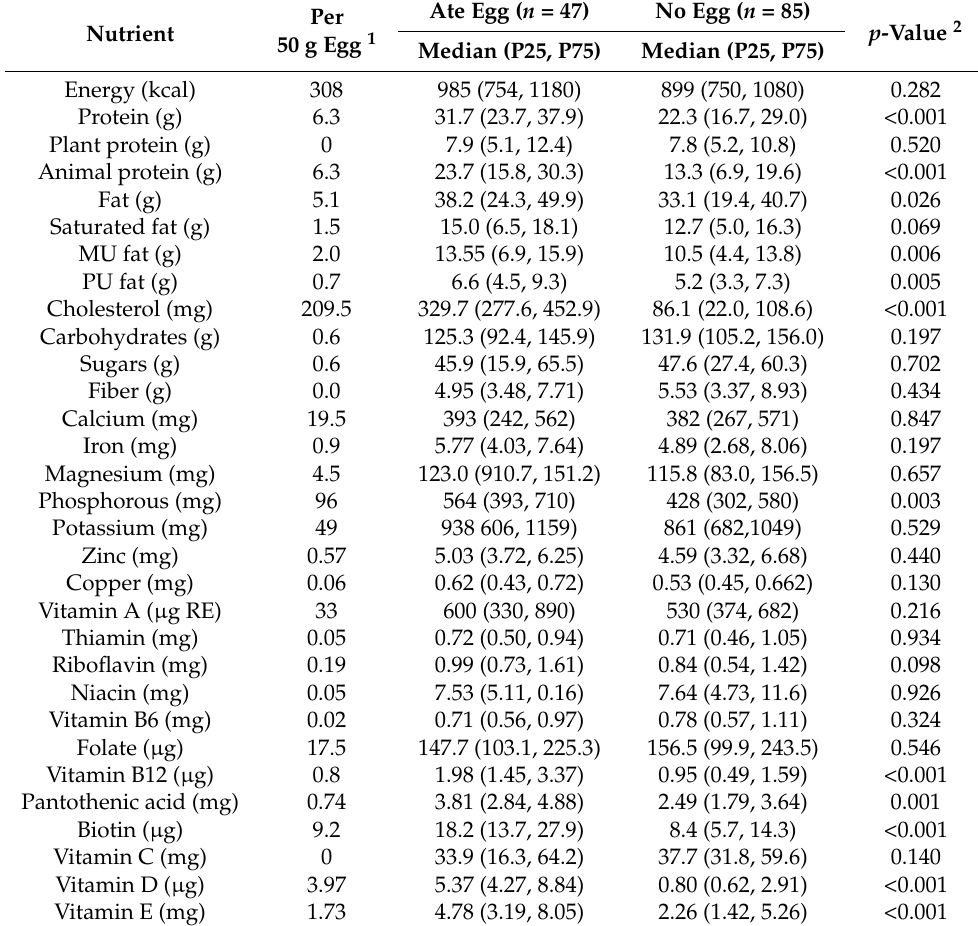
Table 3. Energy, macronutrient, and micronutrient intakes at endpoint for babies who ate egg during the 24-h recall period versus those who did not eat egg, regardless of treatment group.